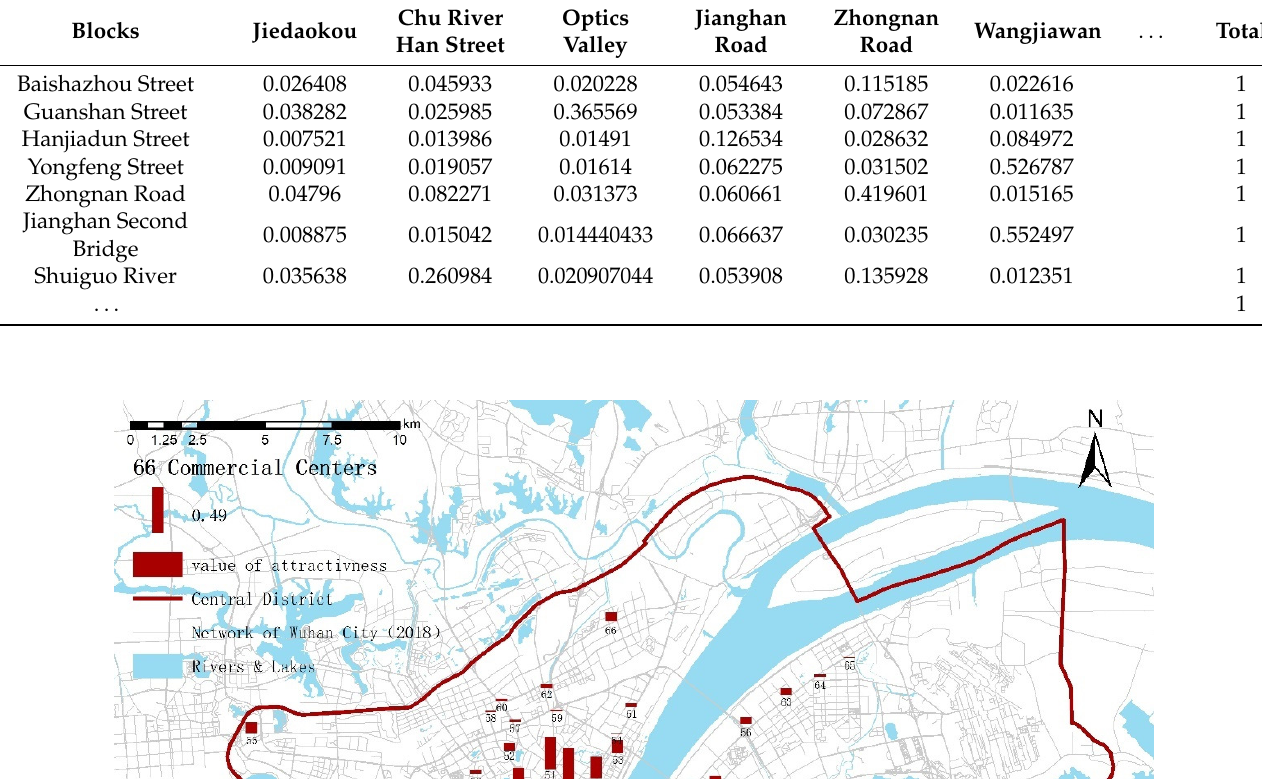
Table 2. Matrix of spatial interaction probability among blocks and commercial centers.